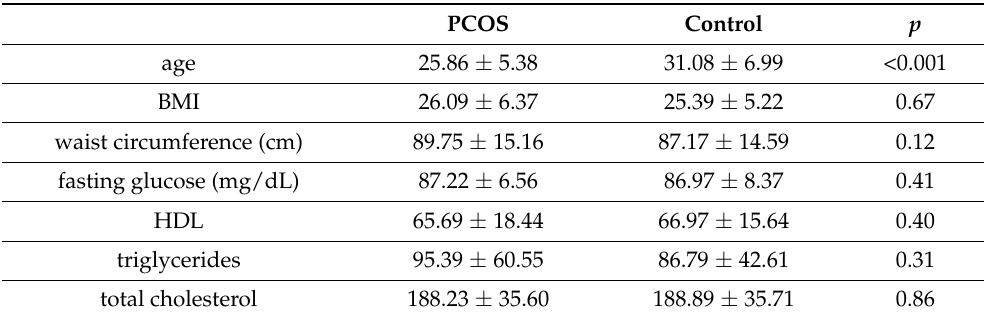
Table 1. Analysis of anthropometrical, biochemical and hormonal parameters in PCOS and con- trol